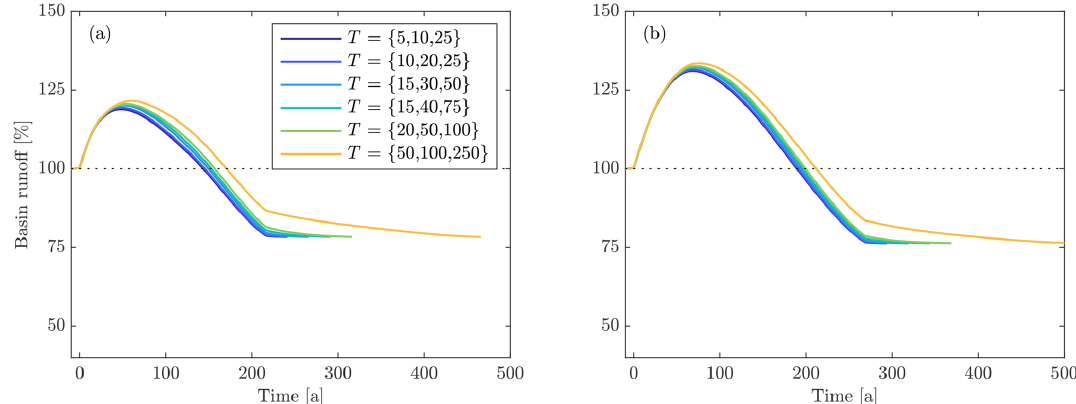
Figure 5. Variations in basin runoff for differing rates of catchment vegetation in (a) maritime and (b) continental climates. The basin slope (5 ◦ ), climate change scenario (RCP8.5), and vegetation type ( C = { 1 , 0 . 95 , 0 . 85 , 0 . 8 } ) are the same in both panels.